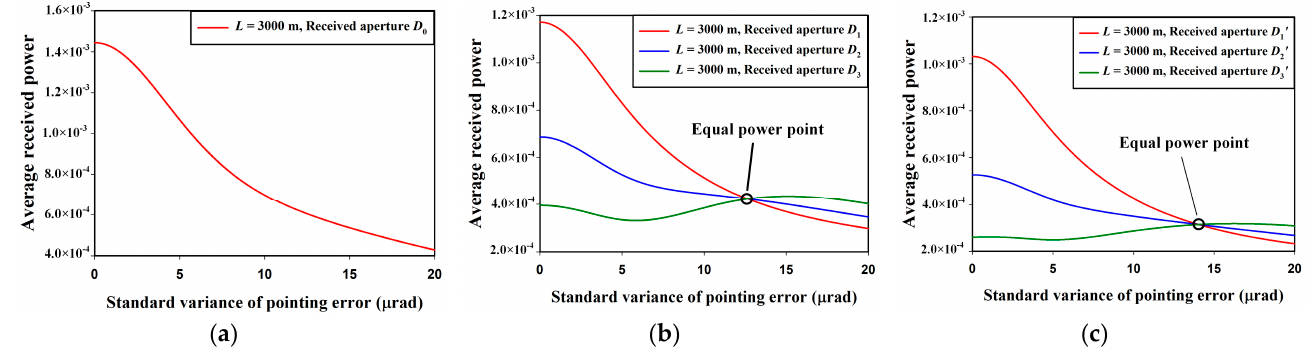
Figure 8. Average received power at the corresponding receiving aperture under the influence of pointing error. ( a ) TEM 11 , ( b ) TEM 22 and ( c ) TEM 33 . As shown in Figure 9, the average irradiance of the TEM 22 HG beam at the “equal power point” σ r = 12.67 µ rad exhibits a flat-topped profile. As shown in Figure 10, the average irradiance of the TEM 33 HG beam at the “equal power point” σ r = 14.05 µ rad exhibits a slightly hollow shape. The average irradiance of the HG beam appears to have a nearly flat-topped shape at the “equal power point”.